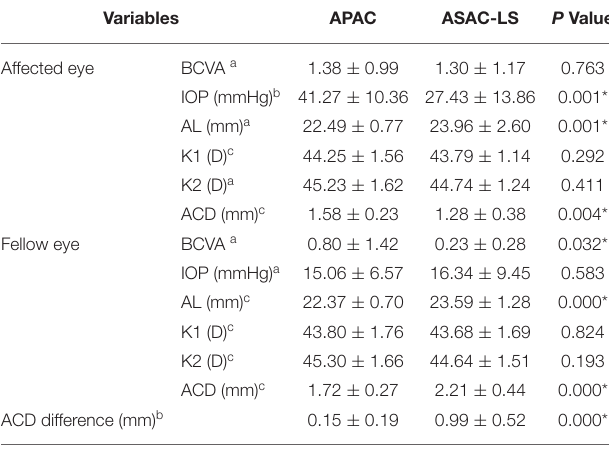
TABLE 2 | The ocular biometric data from both eyes of the ASAC-LS and APAC cohorts. Variables APAC